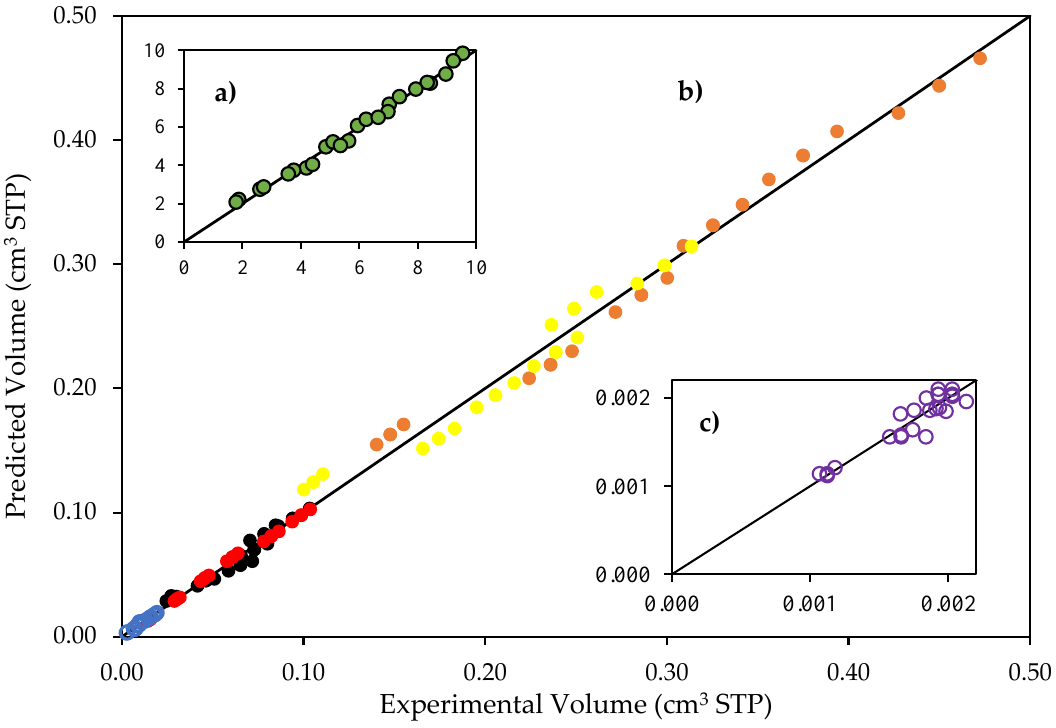
Figure 11. Reconciliation plot for predicted and experimentally observed species volumes. Notes: ( a ) hydrogen volumes, 0 to 10 cm 3 STP; ( b ) CO 2 , CH 4 , C 2 H 4 O, C 2 H 6 and C 2 H 4 volumes, 0 to 0.5 cm 3 ; and ( c ) hydrogen peroxide volumes, 0 to 0.0022 cm 3 STP. Conditions: 0.25 wt% Pd-TiO 2 photocatalyst. Experimental error of ± 5.5%.